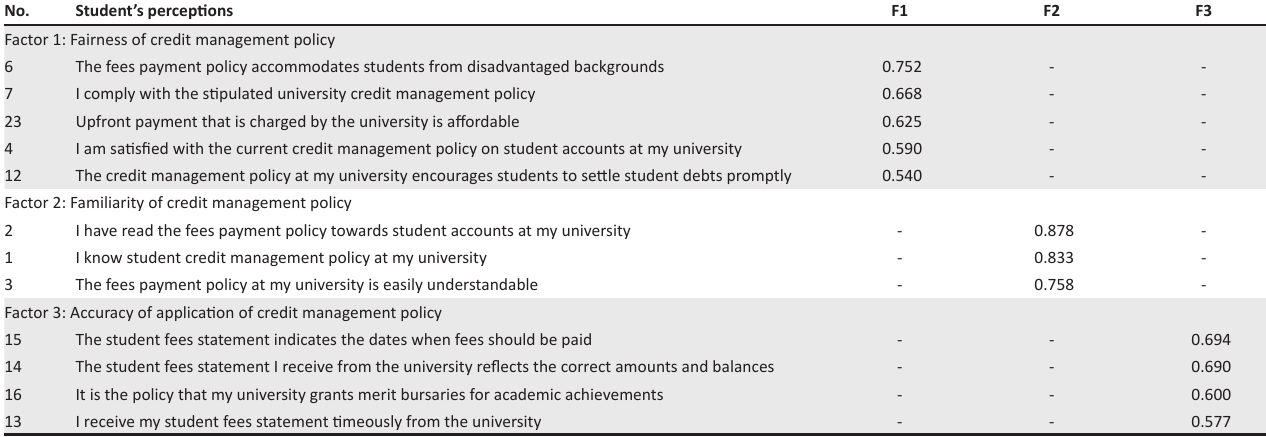
TABLE 3: Factors for students’ perception on appropriateness credit management